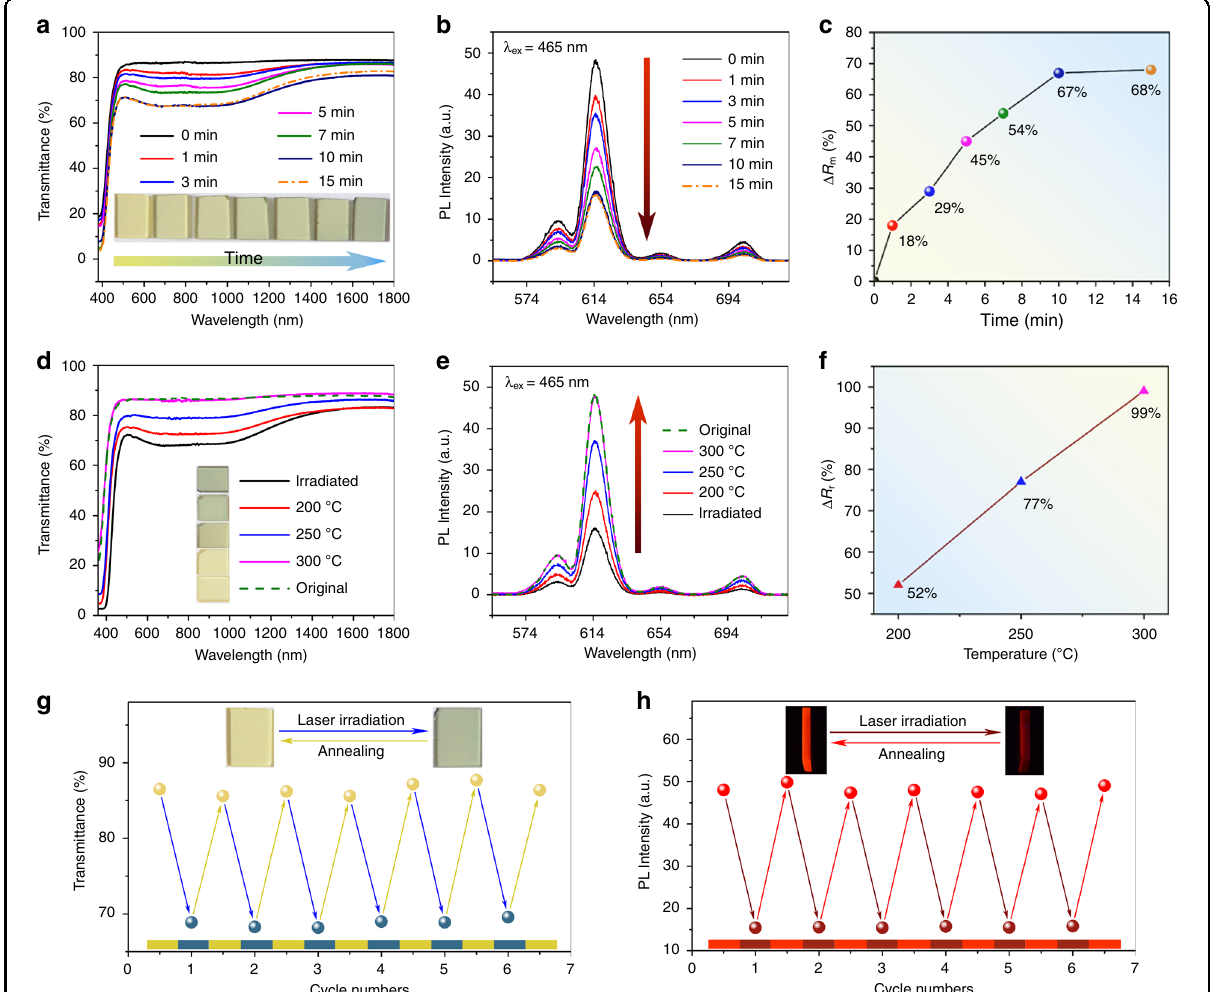
Fig. 2 Reversible photochromism and luminescence modi fi cation. a Transmission spectra and photos of WPG-Sb1 glass irradiated by unfocused 473 nm laser (151.26W cm − 2 ) for various times. b , c Luminescence spectra ( b ) and corresponding modulation degree ( c ) of WPG-Sb1 glass scanned by unfocused 473 nm laser for various times under 465 nm excitation. d Transmission spectra and photos of blue WPG-Sb1 glass heat-treated at various temperatures for 10 min. e , f Luminescence spectra ( e ) and luminescence recovery degree ( Δ R r ) ( f ) of the blue WPG-Sb1 glass bleached by various temperatures for 10 min. g , h 614 nm transmittance ( g ) and luminescence intensity ( h ) of WPG-Sb1 glass by alternating 473 nm laser (151.26W cm − 2 , 15 min) and thermal stimulation (300 °C, 10 min) as a function of cycle